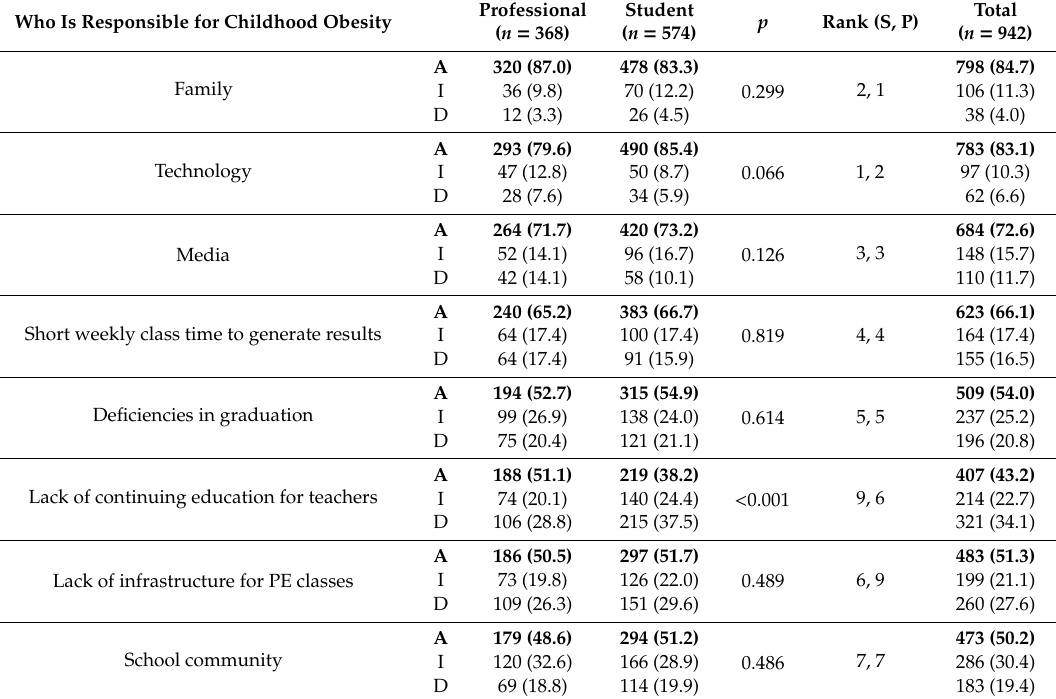
Table 4. Questionnaire on the attribution of responsibility for childhood